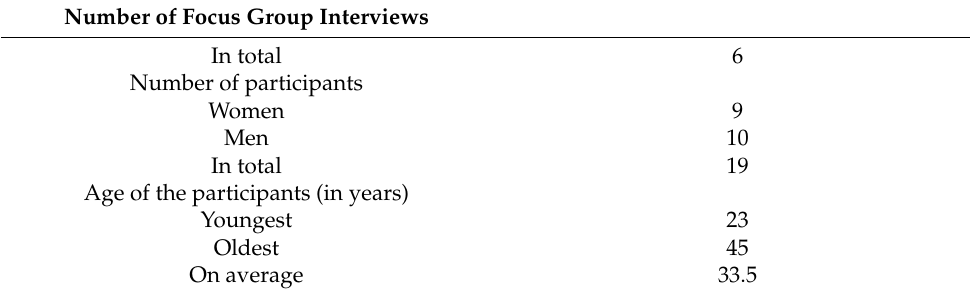
Table 1. Interviews and